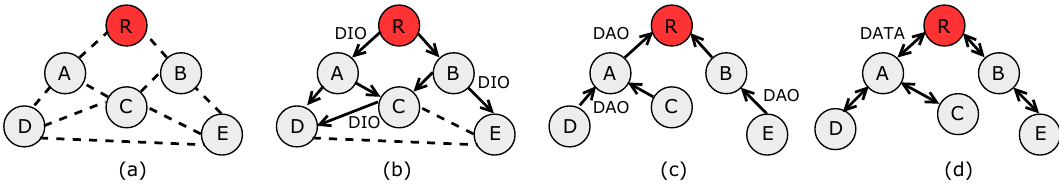
Figure 2. ( a ) A general wireless network. ( b ) Downward route construction. ( c ) Upward route construction. ( d ) Data traffic.